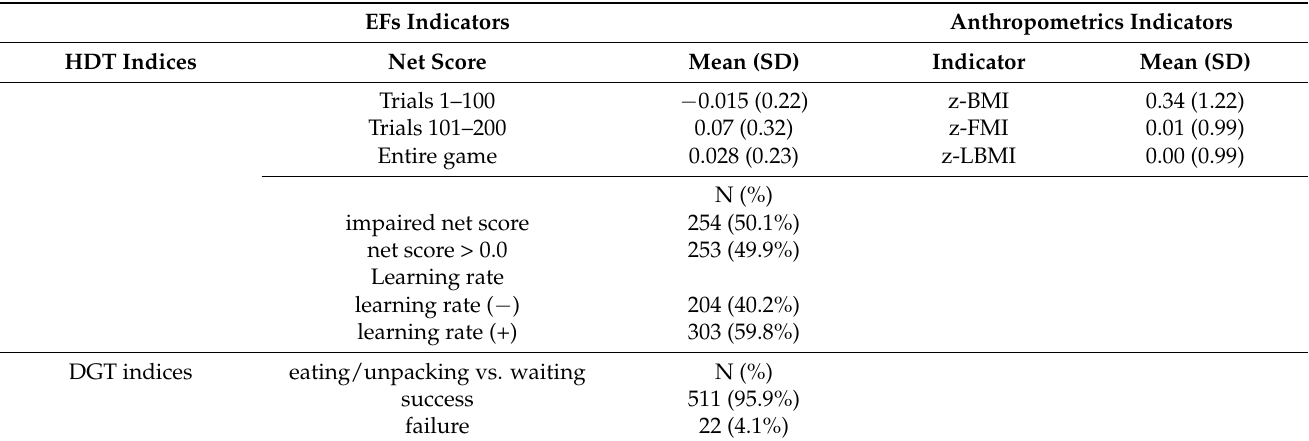
Table A3. Descriptive statistic of the anthropometrics’ and EFs indices for the total